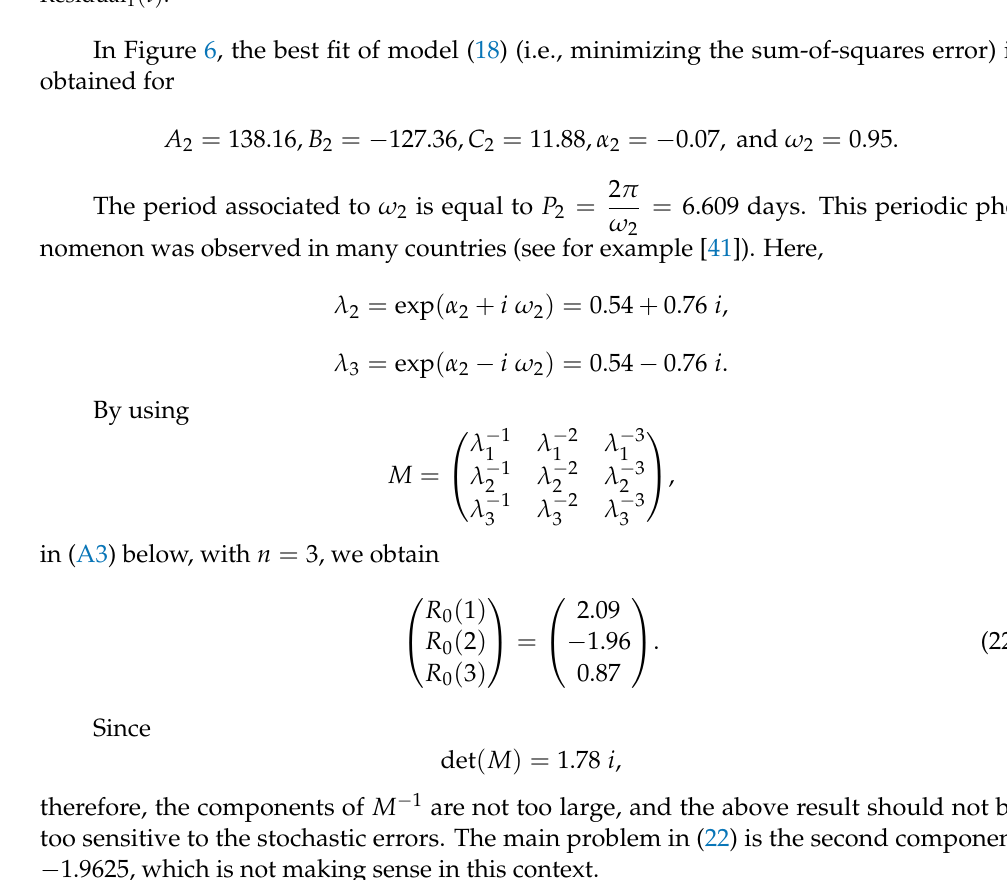
Figure 6. In this figure , the black dots correspond to the function t (cid:55)→ Residual 1 ( t ) from 19 October and 29 October 2020 (black dots). The red curve corresponds to the best fit of model (18) to Residual 1 ( t )